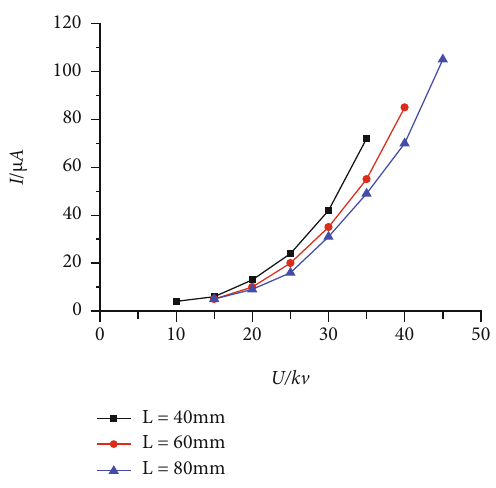
Figure 5: Volt-ampere characteristic curve of water mist. Table 3: Regression equation and parameters of volt-ampere characteristic curve of water mist.